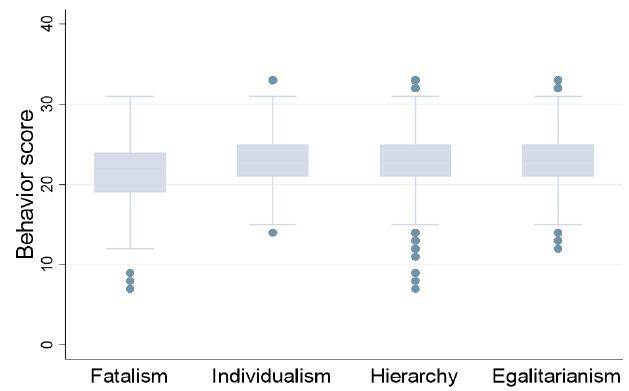
Figure 4. Risk Culture and Pro-environmental Behavior.